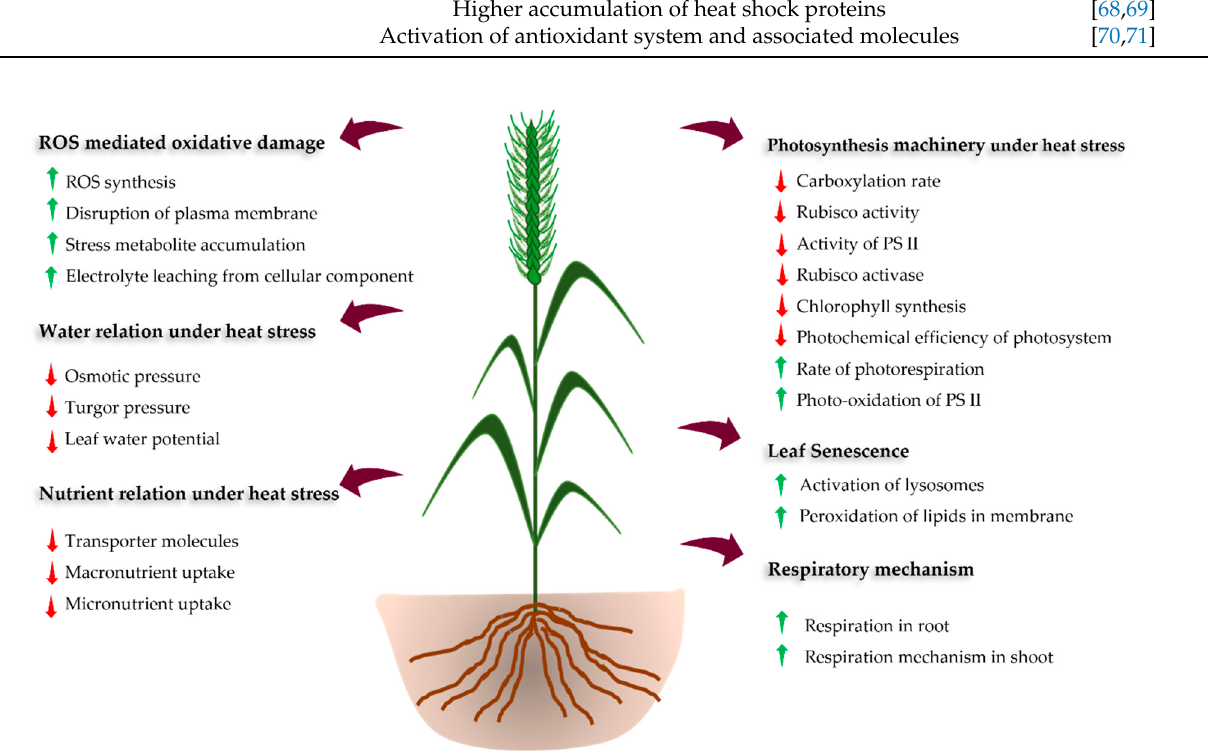
Figure 1. Schematic diagram showing impacts and responses of plants to heat stress. Table 2. Impact of heat stress on different traits/biological processes of wheat.